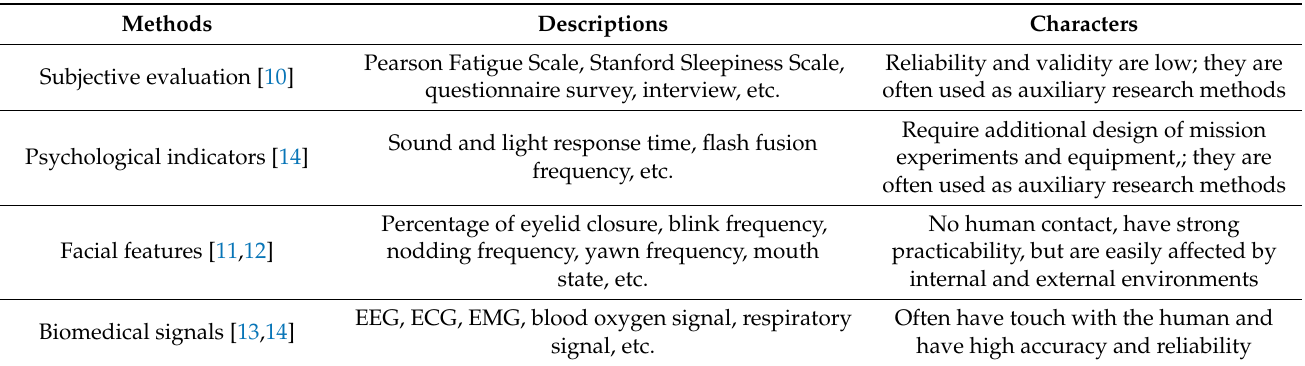
Table 1. Brain fatigue evaluation